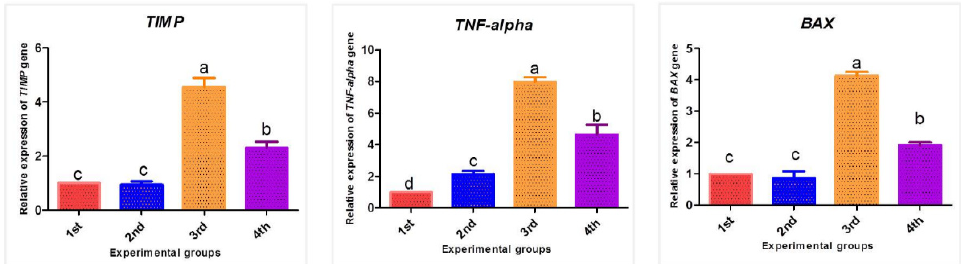
Figure 12. Changes in TIMP-1, TNF- α , and BAX mRNA expression patterns resulting from Fe 2 O 3 - NPs intoxication (30 mg/kg b. wt for 15 days, orally) and PPE (100 mg/kg b. wt) in male albino mice liver tissues. The first group is controlled mice (red column), the second group is PPE-treated mice (blue column), the third group is Fe 2 O 3 -NPs-exposed mice (orange column), and the fourth group is Fe 2 O 3 -NPs plus PPE-treated mice (purple column). Values are expressed as mean ± SE; means differ significantly at p < 0.05 by one-way ANOVA followed by Tukey’s multiple comparison post hoc test. The different letters (a, b, c, d) are different levels of significance ( p < 0.05). The “a” letter indicates high significance, the “b” letter indicates significance, and the “c, d” letters indicate significance.